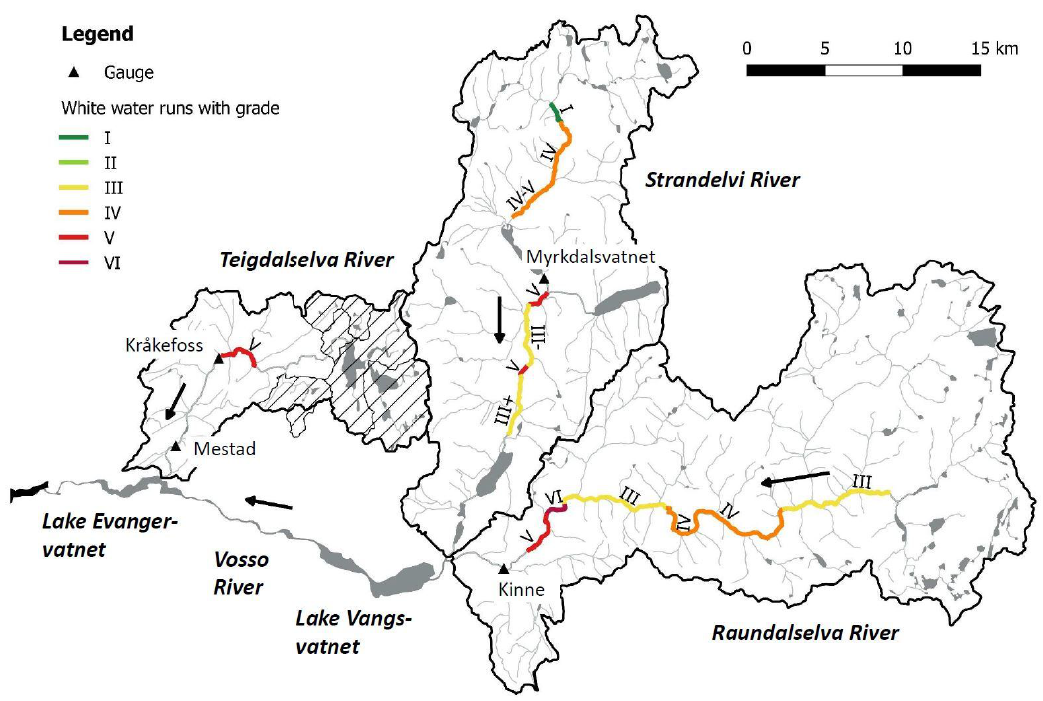
Figure 4. Overview map of the Teigdalselva, Raundalselva and Strandelvi river basins with WW runs and gauges. The upper part of Teigdalselva River basin is affected by water abstraction (hatched zones).